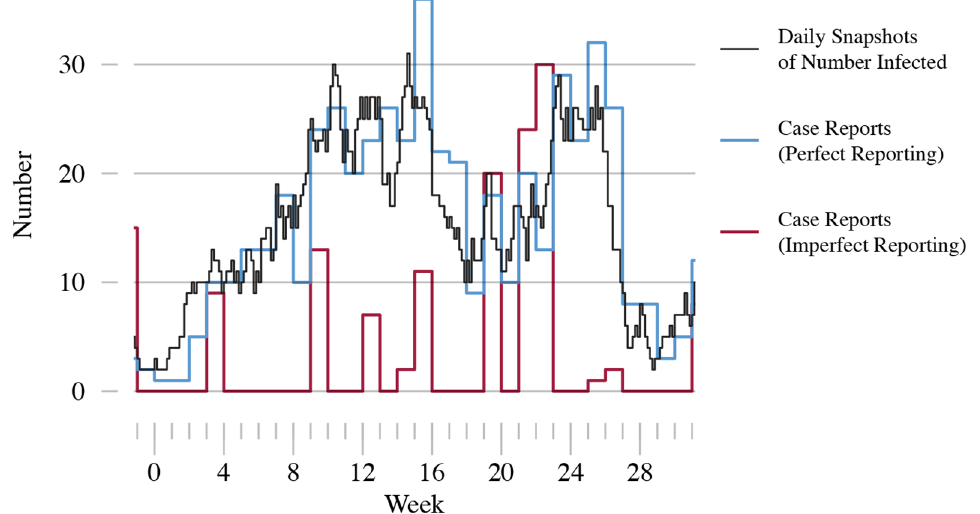
Fig 2. Example of aggregated data with reporting error. Three time series for the same simulated outbreak are shown: daily snapshots of the number of infected (black line), weekly aggregated case reports with no reporting error (perfect reporting, blue line) and weekly aggregated case reports with reporting error (imperfect reporting, red line). Reporting error is modeled using a negative binomial distribution with ρ = 0.25 and ϕ = 0.1. The high overdispersion (small ϕ ) means that there is little visual correspondence between the number of case reports with and without reporting error. Additionally, the number of case reports can exceed the true number of cases (overreporting), in spite of the low reporting rate. SIR simulations performed using the same parameters as Fig